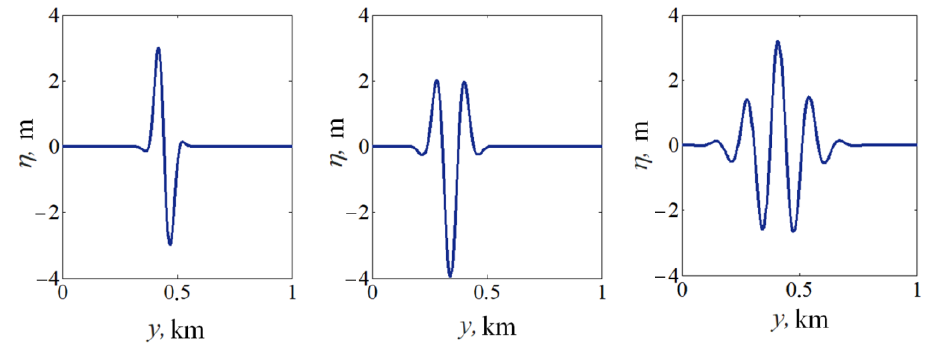
Figure 8. Initial perturbations of different forms at zero moment of time: sign-variable wave ( l = 48 m), a group of anomalous waves of the “two sisters” type ( l = 77 m), and “three sisters” ( l = 150 m).